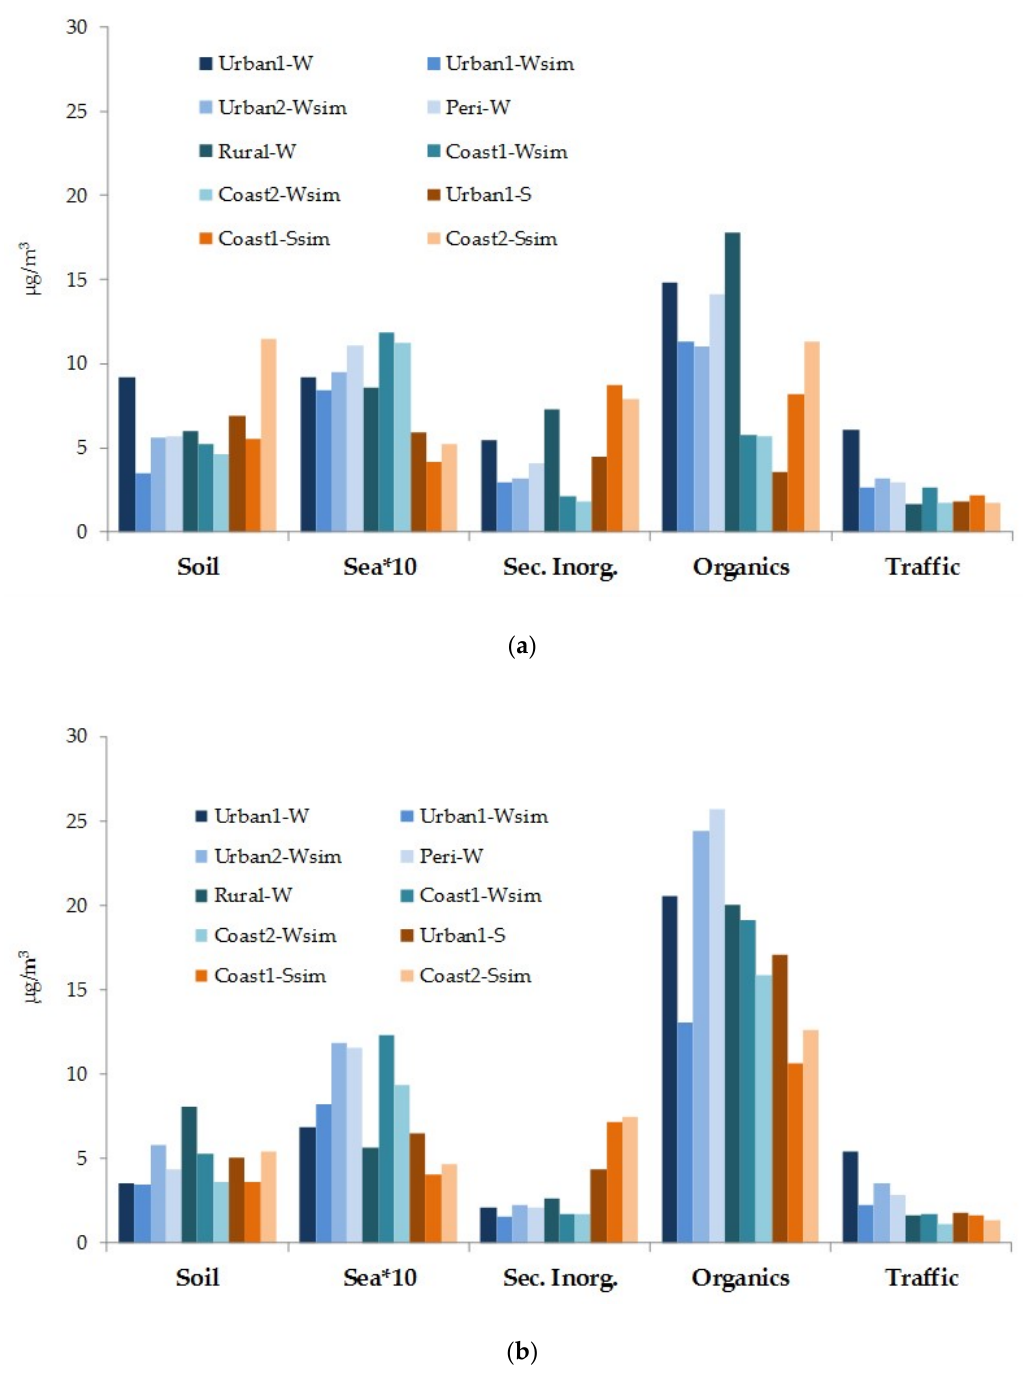
Figure 3. Outdoor ( a ) and indoor ( b ) average contribution of the five macro-sources, in µ g / m 3 ; * sea macro-source values are multiplied by ten. Table 3. Outdoor and indoor particulate matter (PM) composition expressed in terms of the five macro-sources average contribution (in %).